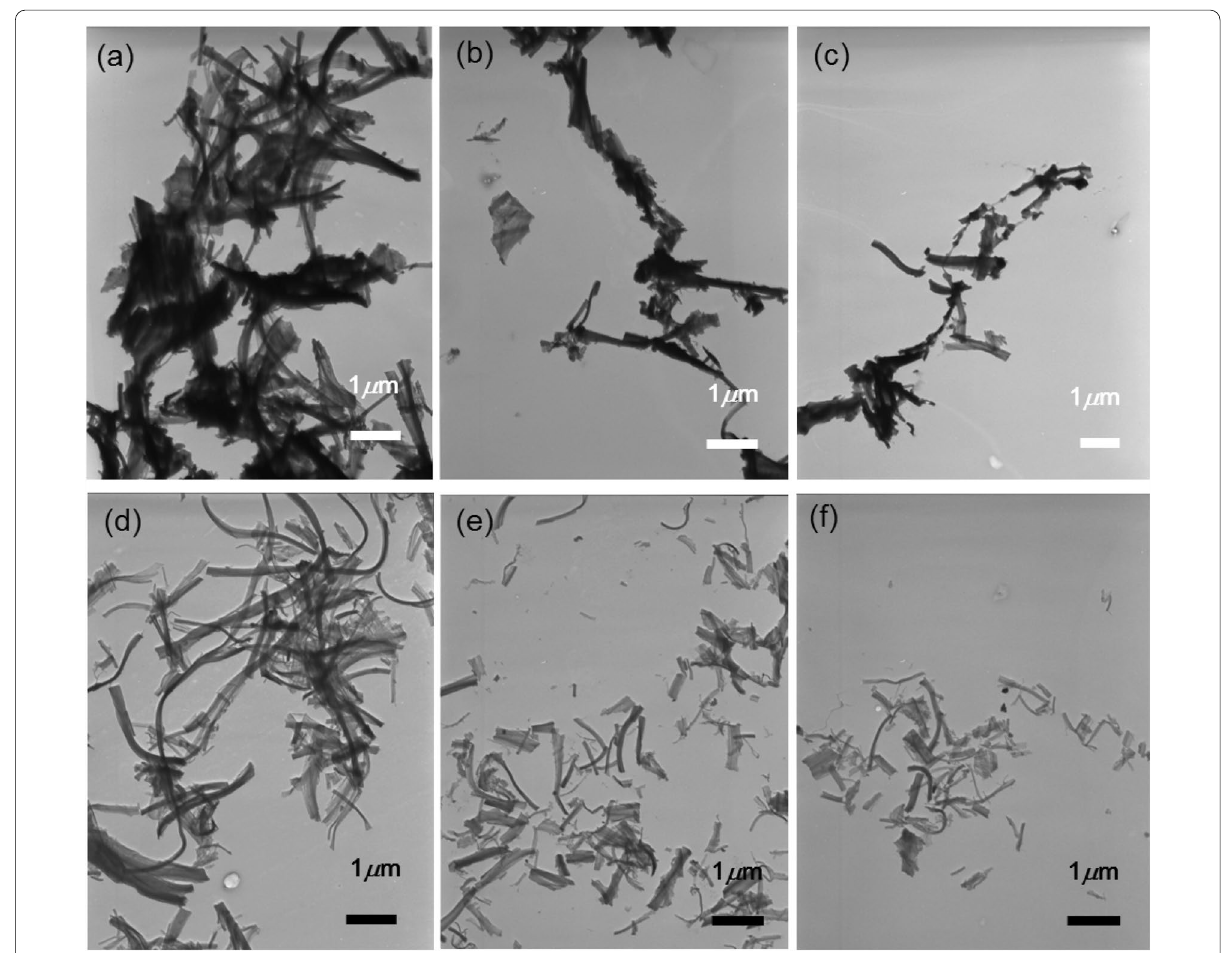
Fig. 5 Transmission electron microscope (TEM) images of 2-h-activated carbon dispersions prepared by aqueous counter collision (ACC) with a 0, b 30, and c 60 passes; and 8-h-activated carbon dispersions prepared by ACC with d 0, e 30, and f 60 passes